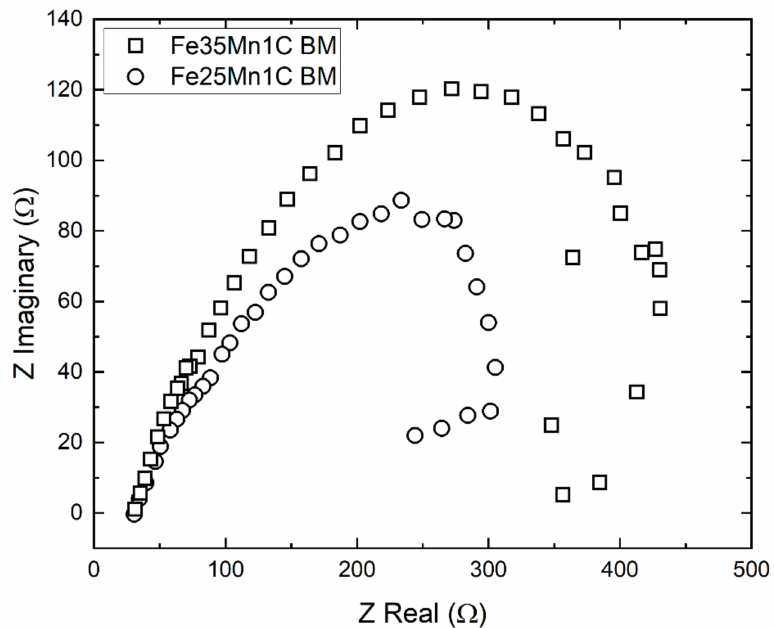
Figure 6. The Nyquist plots of BM samples in the Hank’s